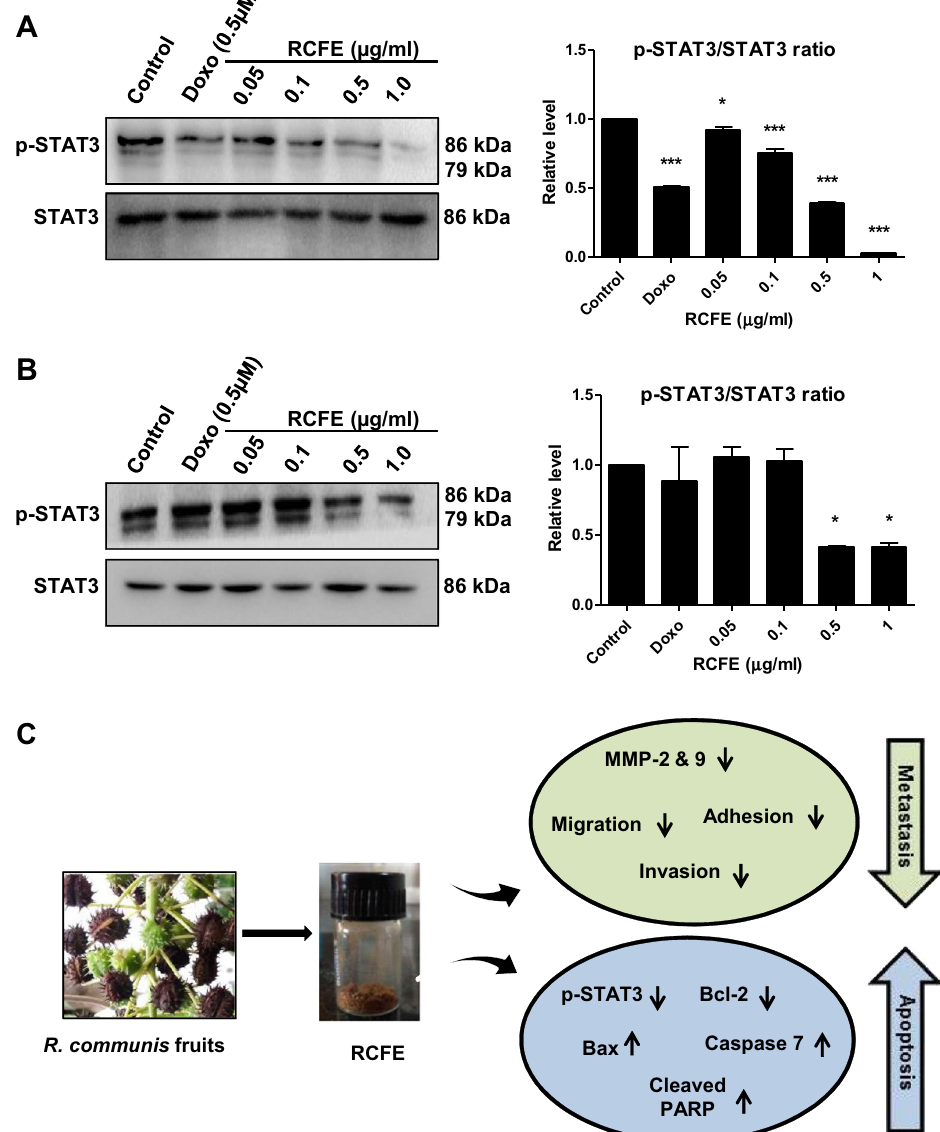
Figure 4. RCFE treatment led to inhibition of STAT3 phosphorylation. Western blot analysis of MCF-7 ( A ) and MDA-MB-231 ( B ) cell lysates with phosphor-STAT3 (Tyr705) and STAT3 antibodies. The quantitation of the expression was presented in right panels. Doxorubicin (Doxo) was used as positive control. Statistical differences of three independent experiments were analyzed with one-way ANOVA test. p value < 0.05 was considered significant. ( C ) Schematic representation of the metastasis inhibition and apoptosis induction by RCFE for its anti-cancer